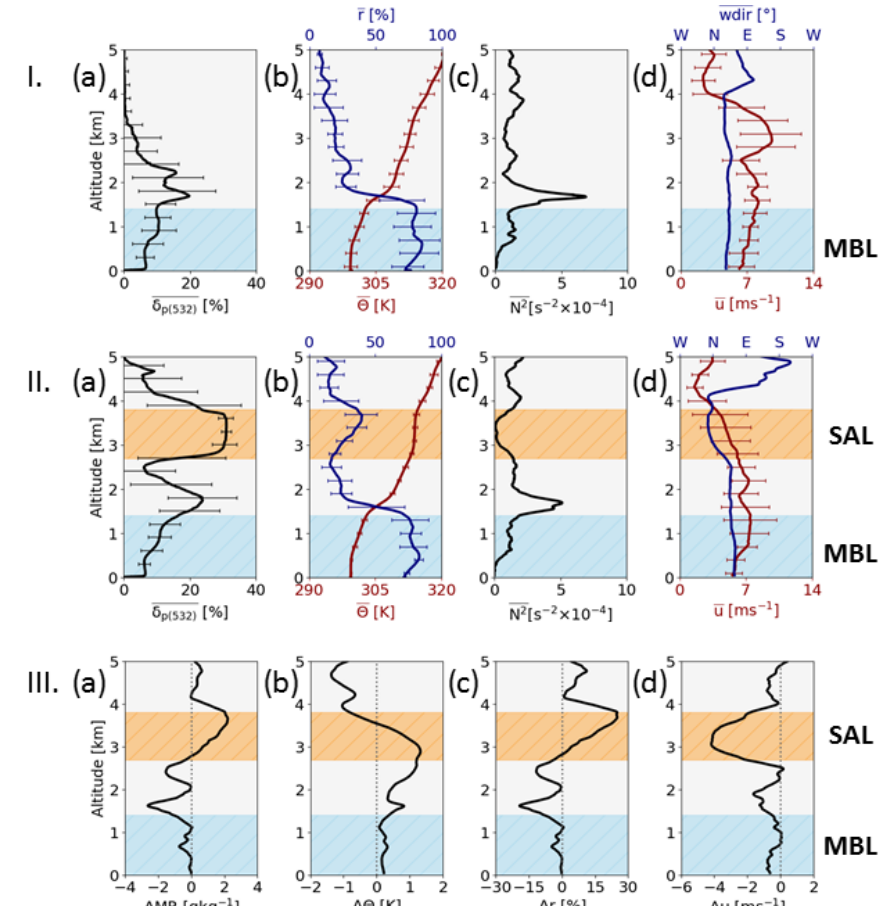
Figure 5. Mean vertical WALES lidar profiles of δ p532 and mean vertical dropsonde profiles of relative humidity ( r ), potential temperature d (cid:50) , and wind speed ( u ) and direction (wdir) in dust-free (I) and dust-laden (II) regions during ( θ ), squared Brunt–Väisälä frequency N 2 = g (cid:50) d z RF6 on 19 August 2016 (horizontal bars indicate standard deviations). (III) Differences in water vapor mass mixing ratio (MR), potential temperature, relative humidity and wind speed between the two regions. Shaded regions mark the marine boundary layer (MBL, blue) and the Saharan air layer (SAL,